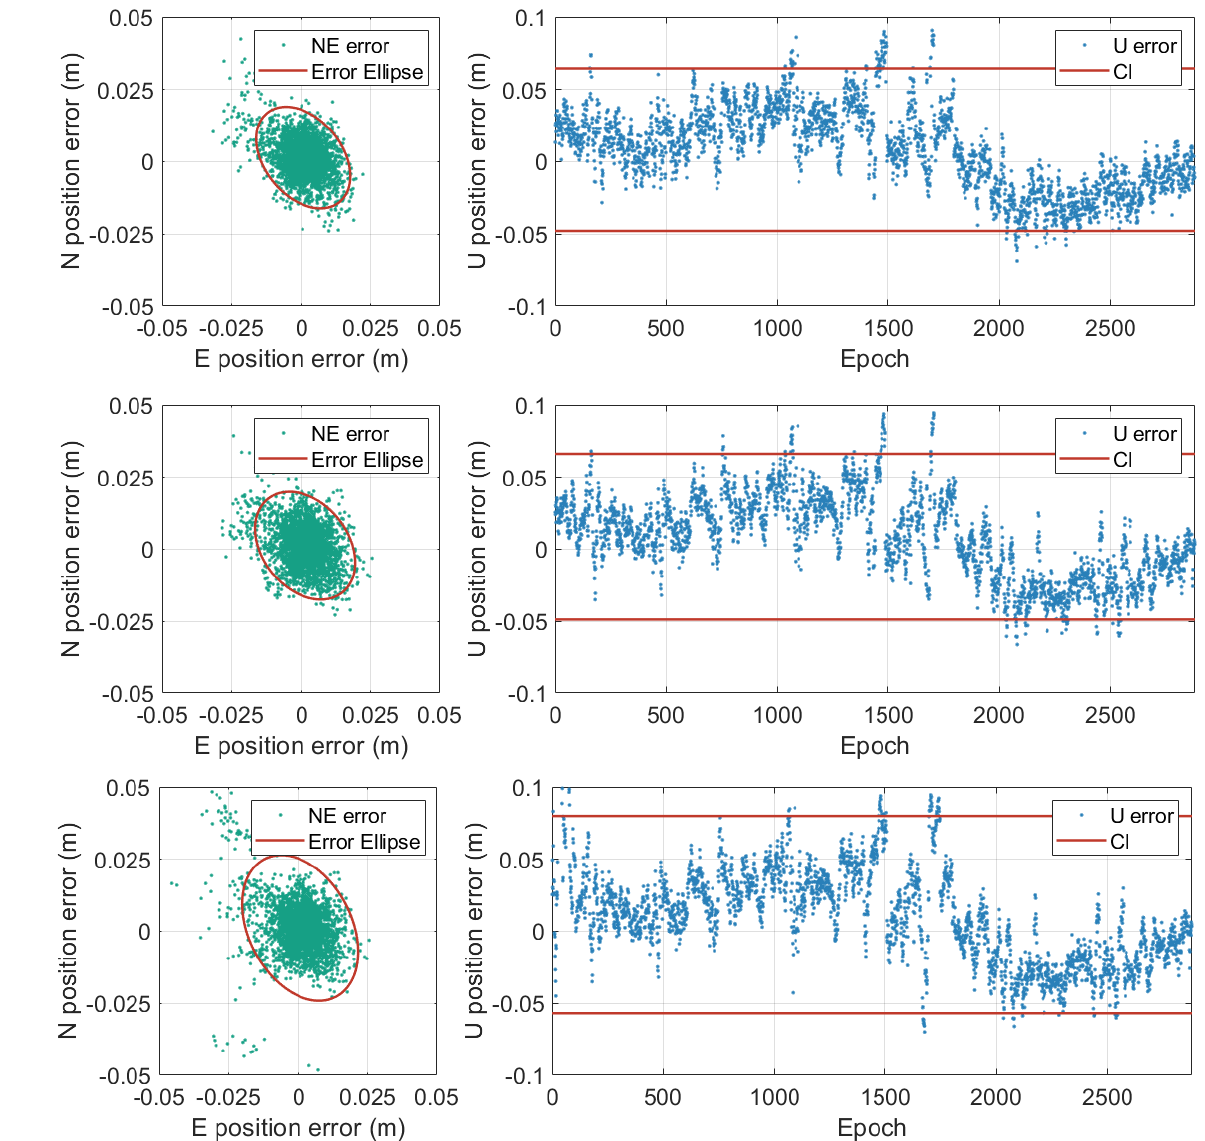
Figure 10. User positioning errors by three models: ( a ) QFIW; ( b ) TFGB; ( c ) DFIF. (N means north direction, E means east direction, NE means north and east directions, U means up direction, CI means confidence interval)